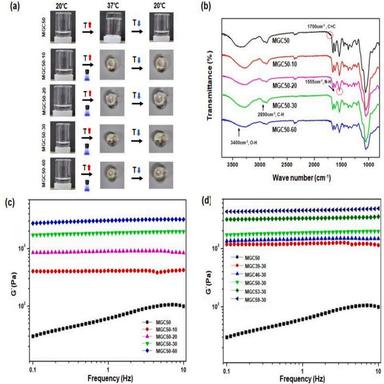
(a) Photographs of MGC50 thermogels after photo-crosslinking (irradiation time = 0, 10, 20, 30, and 60 min), (b) ATR-FTIR spectra of photo-crosslinked MGC thermogels, (c) Change in stroage modulus (G') of photo-crosslinked MGC50 thermogels, and (d) Stroage modulus (G') as a function of MGC thermogels with different substitution degrees.